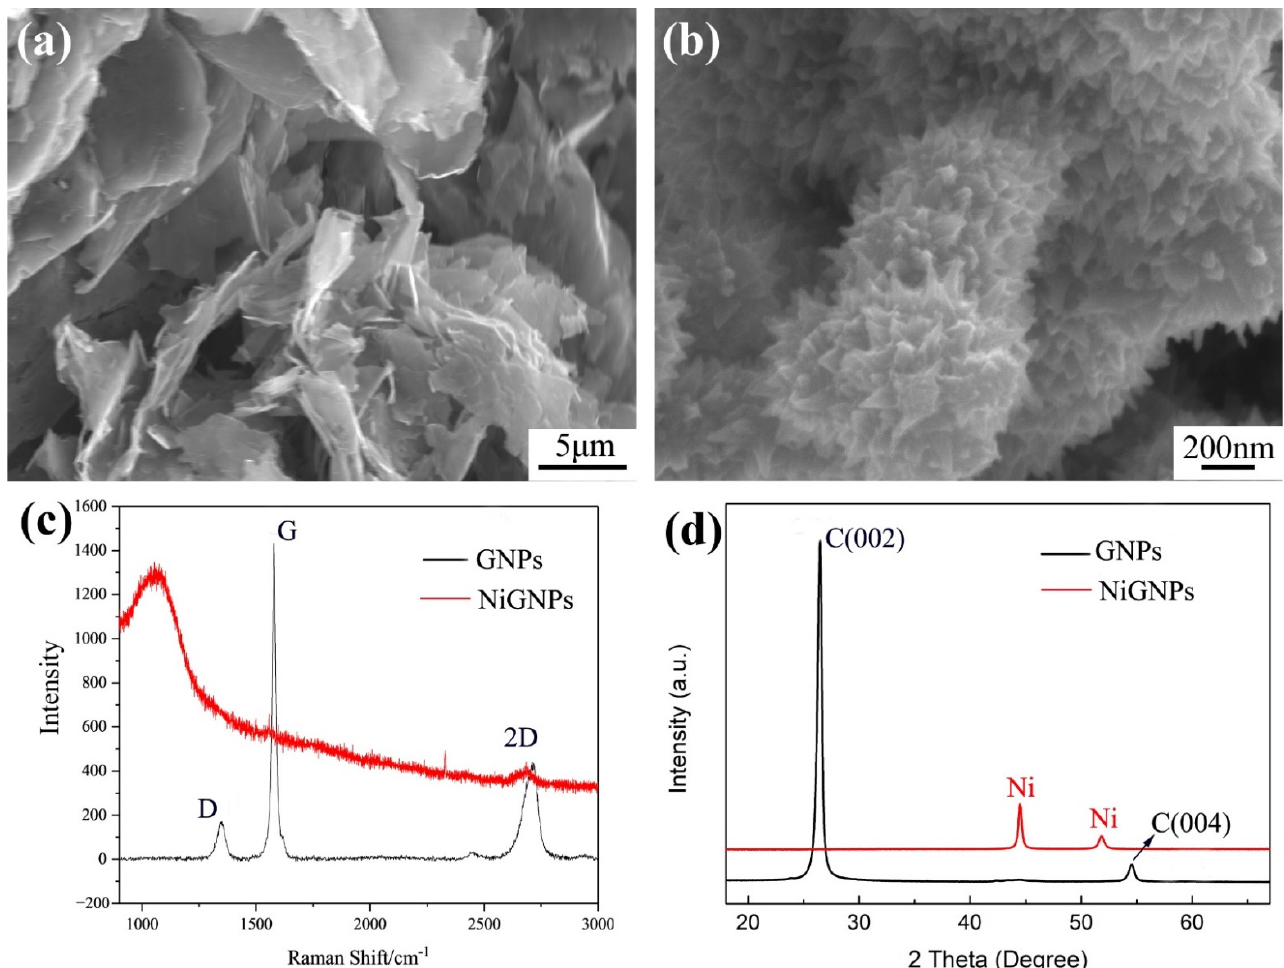
Figure 1. Microstructure analyses of GNPs and NiGNPS: ( a ) SEM image of GNPs, ( b ) SEM image of NiGNPs, ( c ) Raman patterns, ( d ) XRD patterns. Table 3. Laser cladding parameters of GNPs reinforced nickel-based composite coatings.